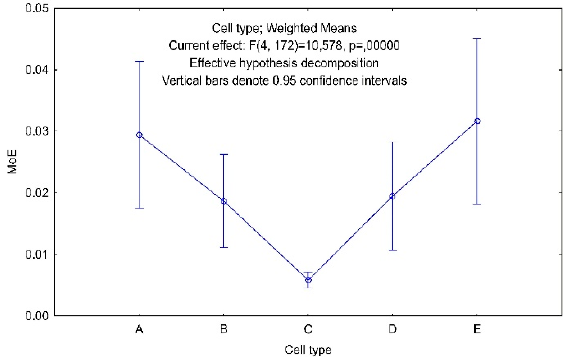
Figure 16. Tukey HSD test result for factor Cell type.